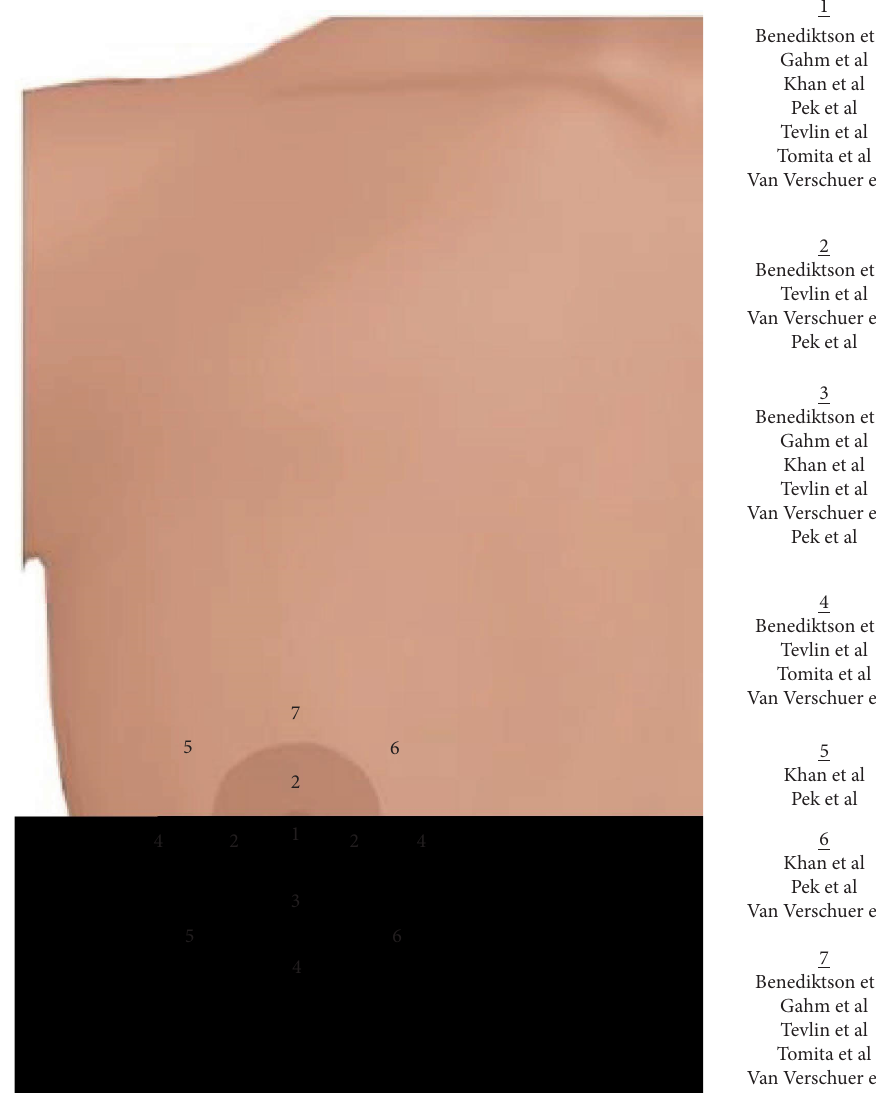
Figure 2: Locations of monoflament sensory